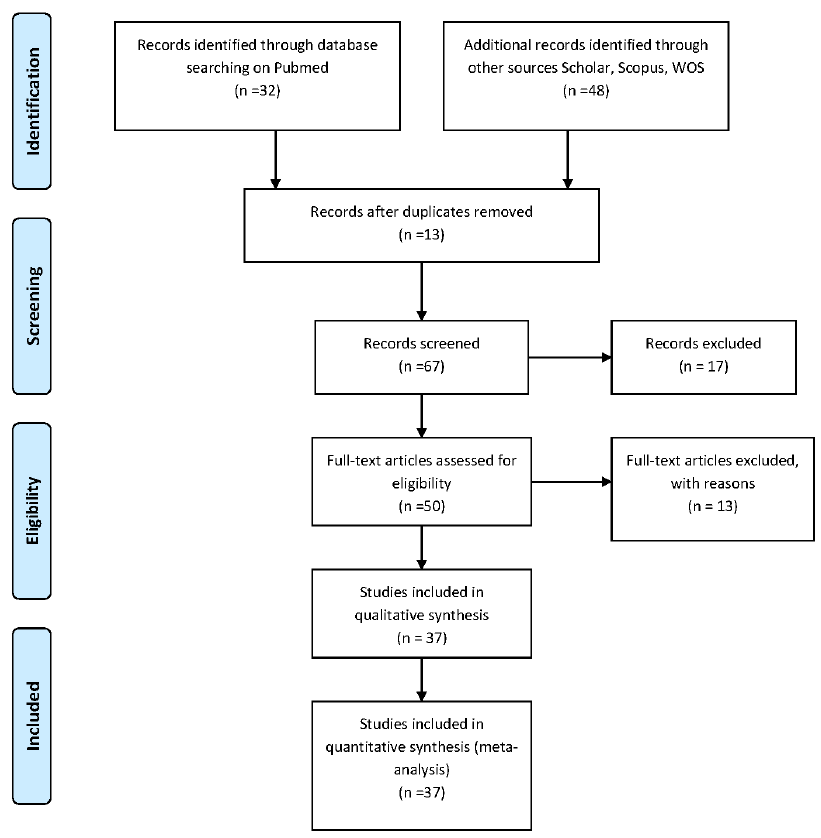
Figure 1. Flow diagram of the review process. WOS, web of science.